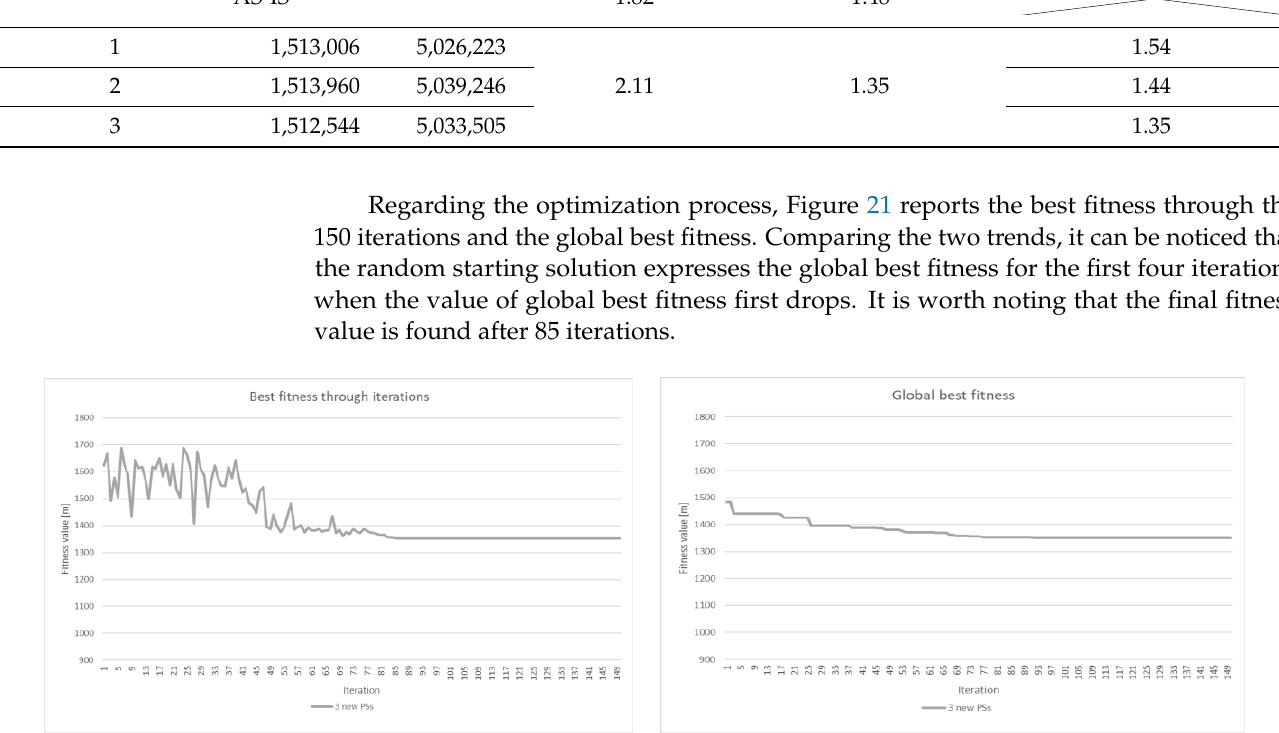
Table 1. Matrix of new and current PSs location. Particles i 𝒙 𝒊𝑵𝒆𝒘 𝑷𝑺𝟏 (𝒕) 𝒚 𝒊𝑵𝒆𝒘 𝑷𝑺𝟏 (𝒕) 𝒙 𝒊𝑵𝒆𝒘 𝑷𝑺𝟐 (𝒕) 𝒚 𝒊𝑵𝒆𝒘 𝑷𝑺𝟐 (𝒕) 𝒙 𝑪𝒖𝒓 𝑷𝑺𝟏 (𝒕) 𝒚 𝑪𝒖𝒓 𝑷𝑺𝟏 (𝒕) … … 𝒙 𝑪𝒖𝒓 𝑷𝑺𝟏𝟑 (𝒕) 𝒚 𝑪𝒖𝒓 𝑷𝑺𝟏𝟑 (𝒕) 1 1,511,310 5,030,533 1,504,760 5,033,038 1,512,544 5,033,515 … … 1,505,567